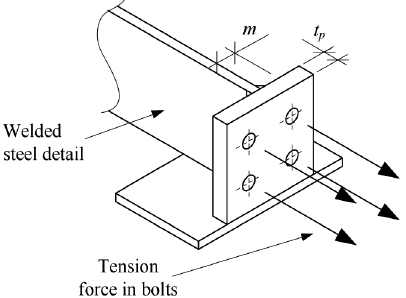
Fig. 2. Welded steel detail’s parameters for bolted end-plate stiffness coefficient